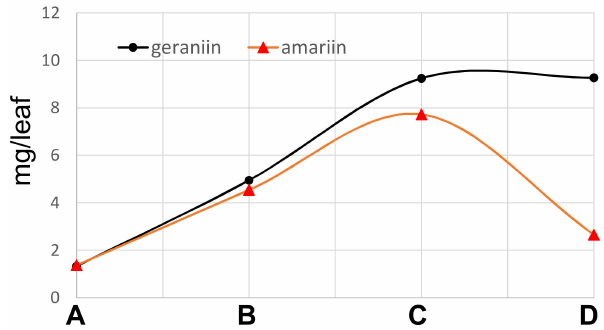
Figure 2. Concentration of amariin ( 1 ) and geraniin ( 2 ) per leaf at di ff erent growing stages. A–D: see Figure